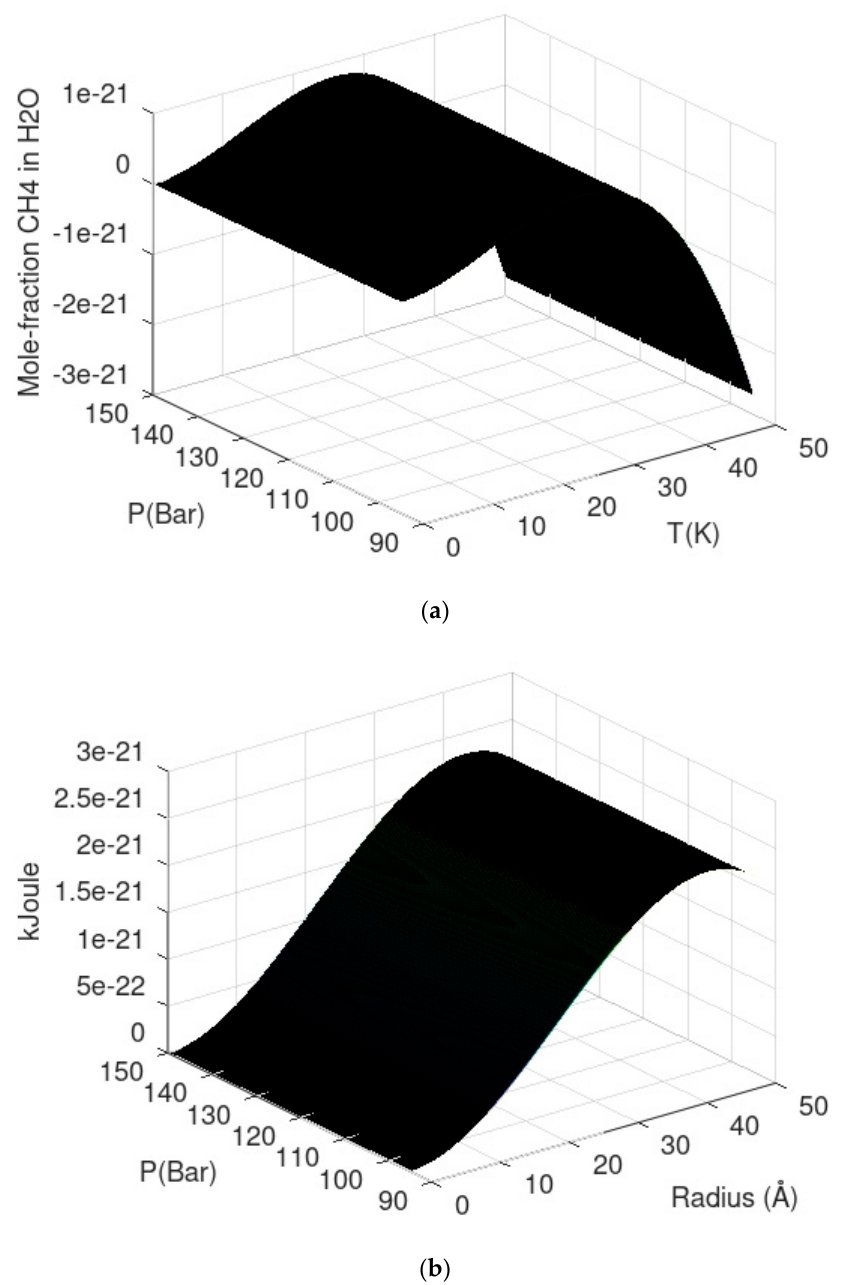
Figure 16. Total Gibbs free energy change for CH 4 hydrate nucleation as function of pressure and radius of hydrate core for two temperatures, ( a ) is 277 K and ( b ) 285.15 K. Critical nuclei size as function of temperature for CH 4 for hydrate nucleation is plotted in Figure 17 and corresponding nucleation times are plotted in Figure 18.